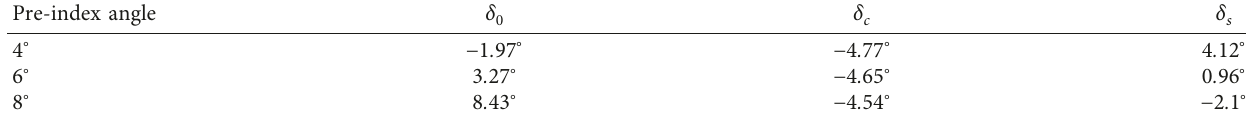
Table 3: The trimming results of the flap deflection of the ECR with different pre-index